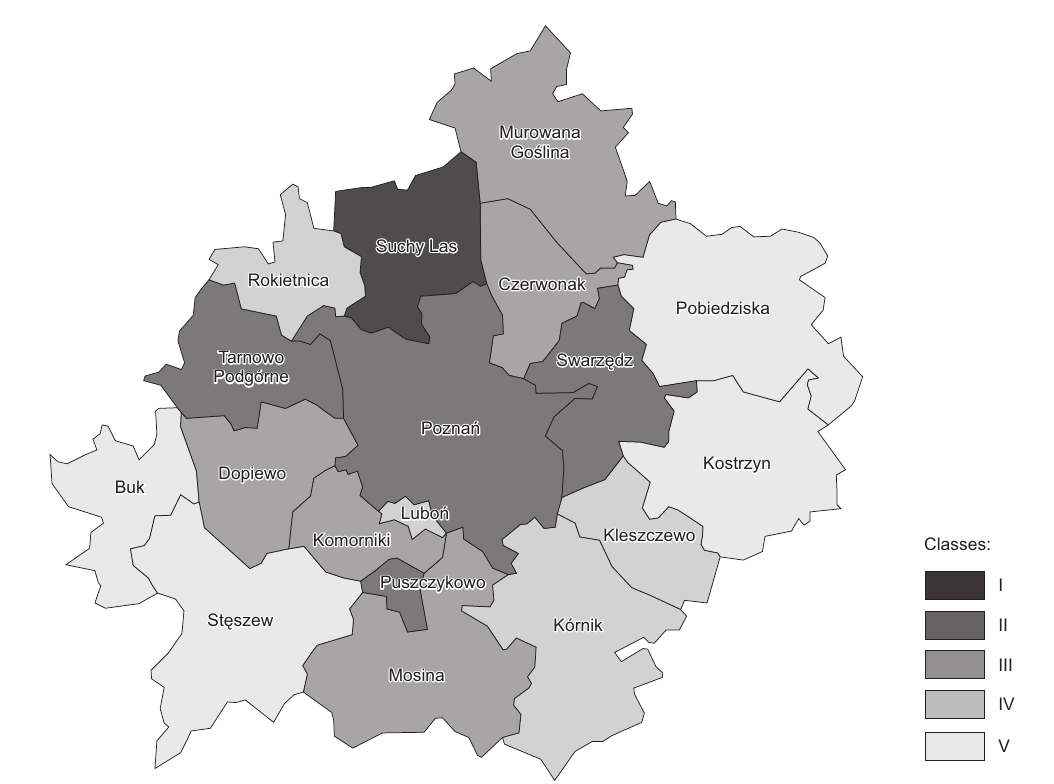
Map 1. Classification of communes in terms of the synthetic indicator of determinants of the quality of life.